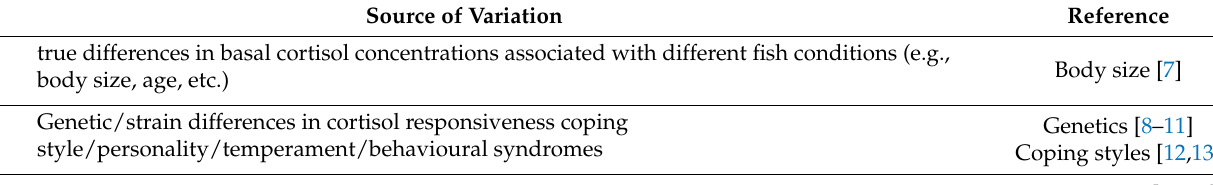
Table 1. Suggested sources of variation in cortisol levels of E. sea bass presented by Ellis et al. (2012) [6], and the respective factors that have been studied thereinafter. Source of Variation